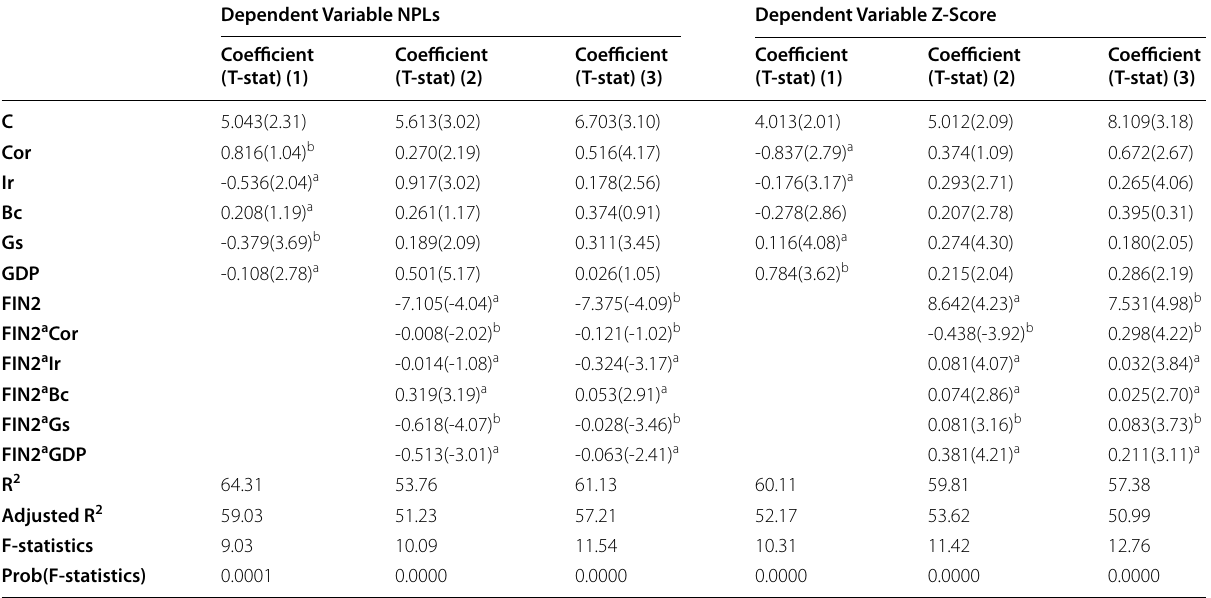
Table 6 Regression